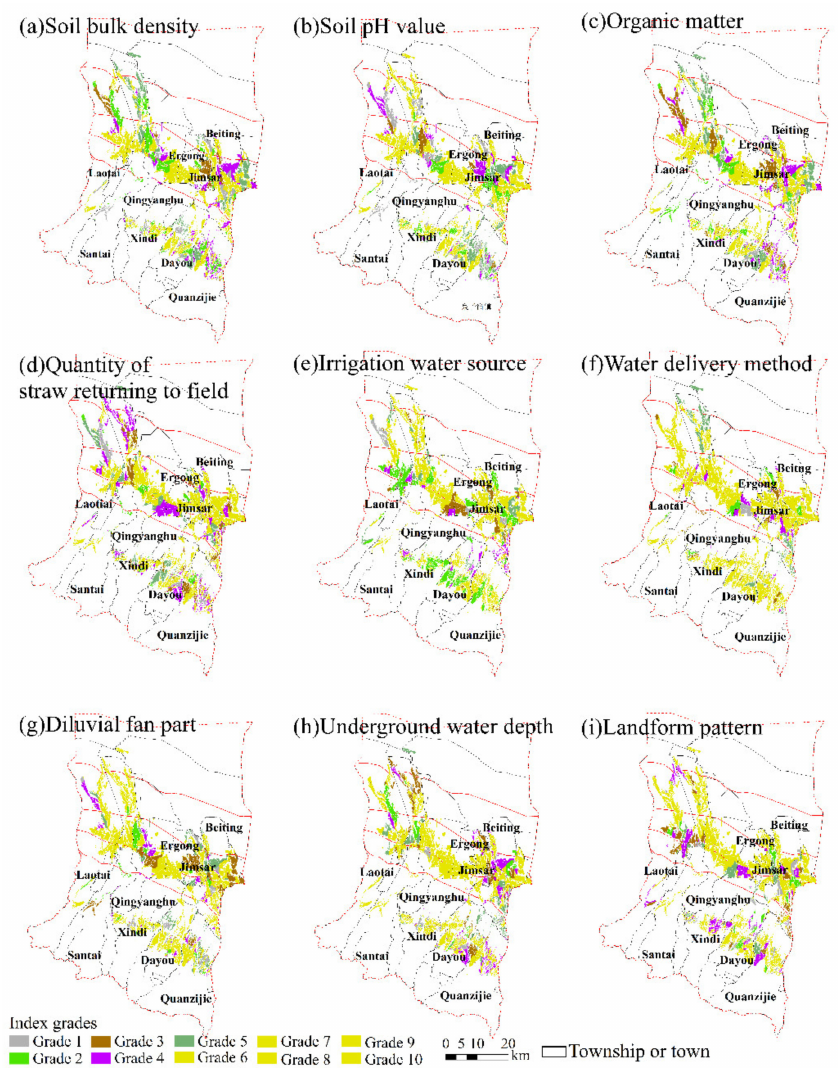
Figure 5. Spatial distribution of the cultivated land quality influential factors. ( a ) Soil bulk density, ( b ) Soil pH value, ( c ) Organic matter, ( d ) Quantity of straw returning to the field, ( e ) Irrigation water source, ( f) Water delivery method, ( g ) Diluvial fan part, ( h ) Underground water depth, and ( i ) Landform